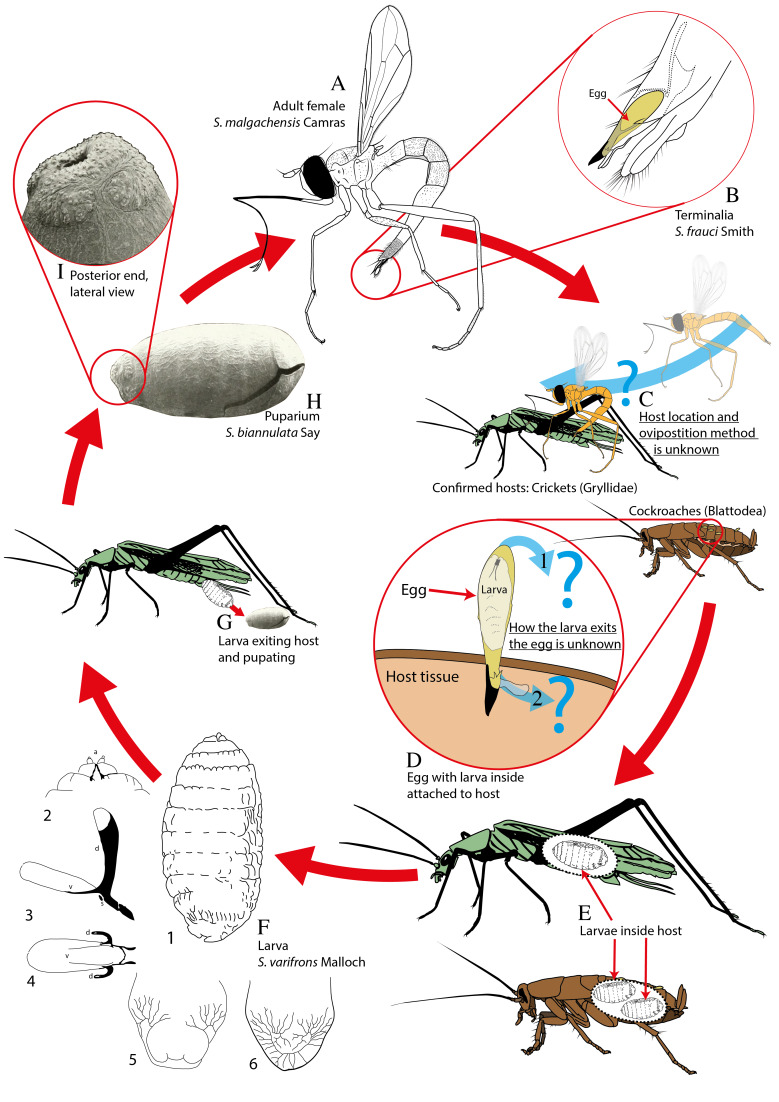
Lifecycle of Stylogaster. A. Adult female of S.
malgachensis Camras; notice the bent abdomen which the females flicks when hovering in flight (Rettenmeyer 1961a, Kotrba 1997); B. Close-up of terminalia from S.
frauci Smith. Egg lodged in terminal chamber with anti-micropylar end protruding; C. Host location and ovipostition method unknown (Kotrba 1997). Confirmed hosts: Crickets (Gryllidae) and cockroaches (Blattodea); D. Egg attached to host. Anti-micropylar end is inside the host, extrusible sac and spines keeping the egg from falling off (2). How the larva exits the egg is unknown, the two proposed ways are illustrated (1 and 2); E. Larvae developing inside hosts; F. Illustration of Stylogaster larva, S.
varifrons Malloch (Smith and Cunningham-Van Someren 1985). 1 Whole larva in left lateral view. 2 Ventral view of anterior end showing antennae and mouthparts. 3 Cephalopharyngeal skeleton in lateral view and 4 dorsal view. 5 Posterior end of larva showing network of tracheoles in ventral view and 6 dorsal view; G. Larva exiting host from the end of the abdomen and pupating (Etzler et al. 2020); H. SEM of Stylogaster puparium, S.
biannulata (Say) and close-up of I. posterior end, lateral view (Woodley and Judd 1998). The method of oviposition (C) and how the larva exits from the egg and enters the host (D) are still unknown, shown by blue arrows and question marks (?). Compiled from literature and based on (A, C) S.
malgachensis Camras, (B, D) S.
frauci Smith, (E, F, G) S.
varifrons Malloch and (G, H, I) S.
biannulata (Say), as all life stages from a single species were not available. Modified from Smith (1967), Smith and Cunningham-Van Someren (1985), Kotrba (1997), Woodley and Judd (1998).